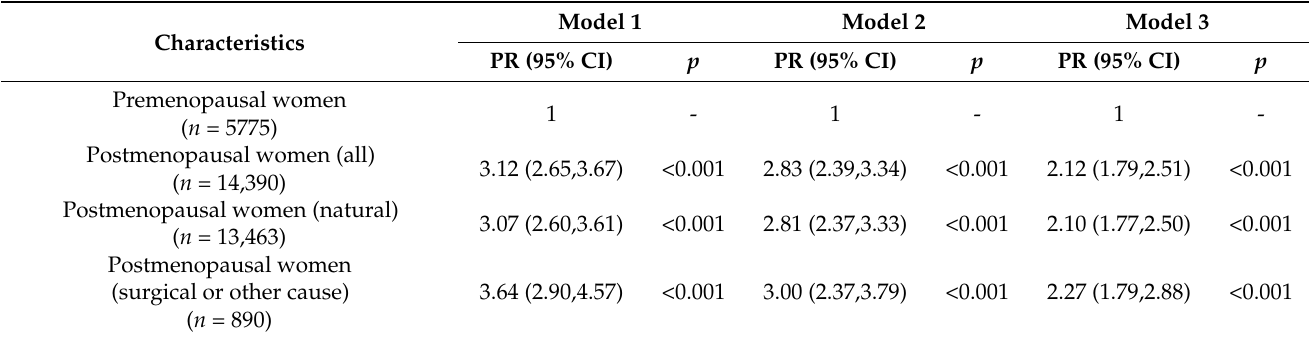
Table 2. Prevalence ratios (PR) (95%CI) for T2DM in premenopausal and postmenopausal